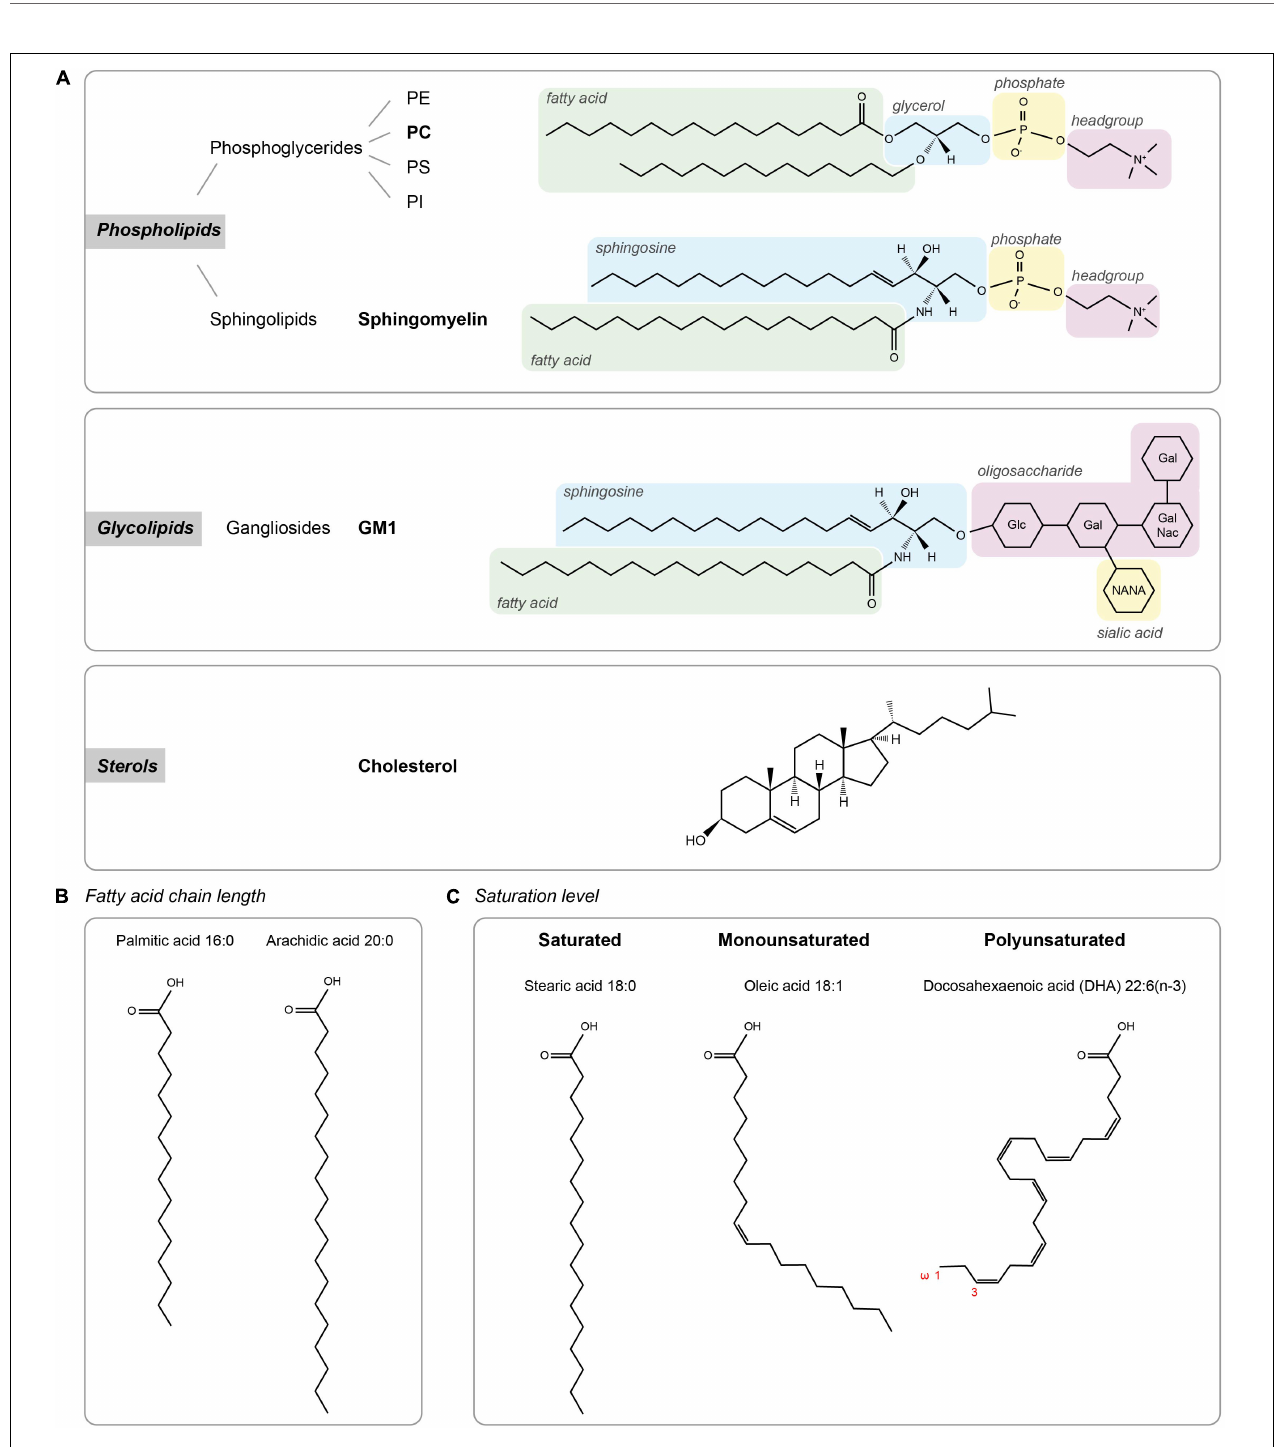
FIGURE 1 | Lipid types. (A) The three major classes of membrane lipids (phospholipids, glycolipids, and sterols) with an example lipid structure (bold) for each. Glc – D -glucose, Gal – D -galactose, NANA – N-actylneuraminic acid, and GalNac – N -acetyl- D -galactoseamine. (B,C) Acyl chain composition. (B) Fatty acid chain length for palmitic acid and arachidic acid. (C) Lipid structures of lipids with different saturation levels (stearic acid, oleic acid, and docosahexaenoic acid).